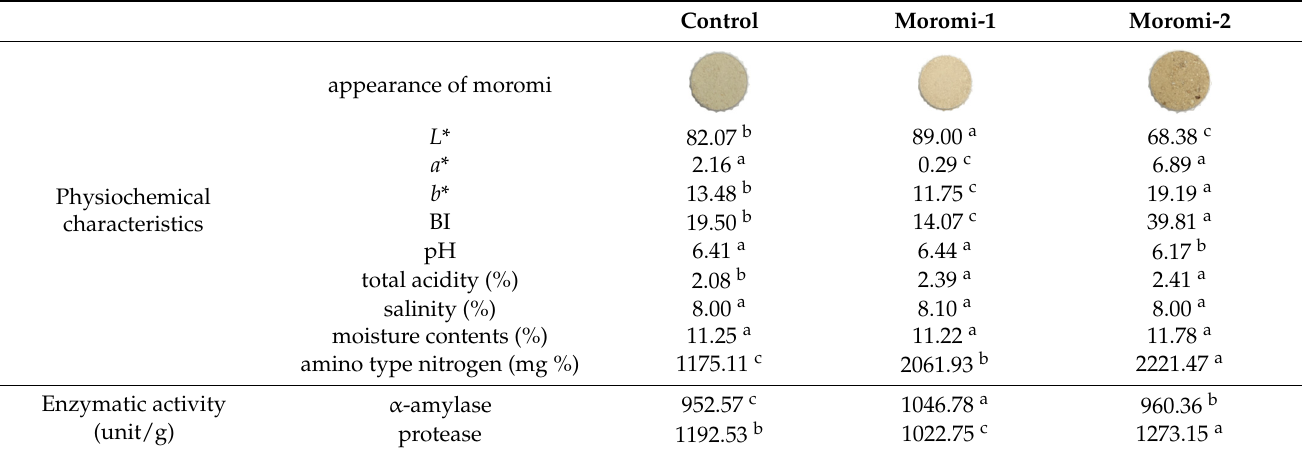
Table 1. Physiochemical characteristics and enzymatic activities of the moromi fermented with different Aspergillus oryzae strains.